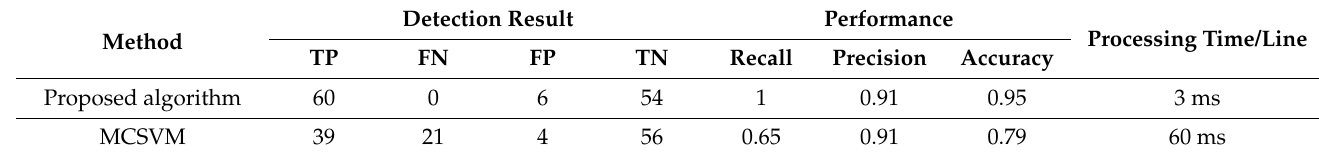
Table 4. Detection performance of each algorithm.